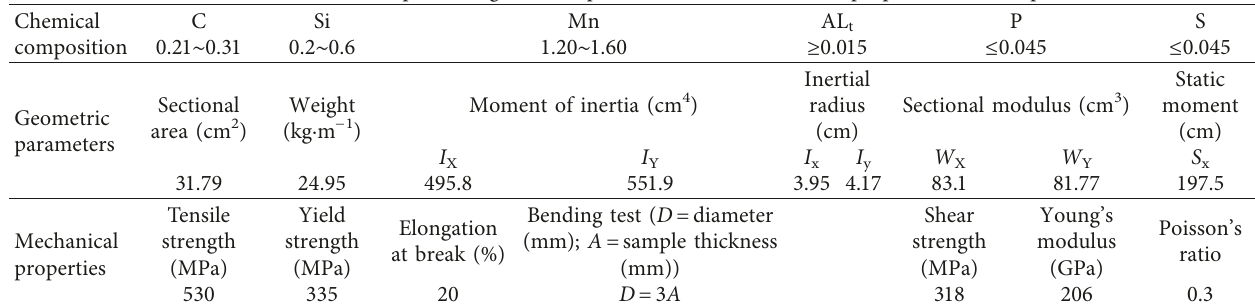
Table 2: The chemical composition, geometric parameters, and mechanical properties of U-shaped steel.